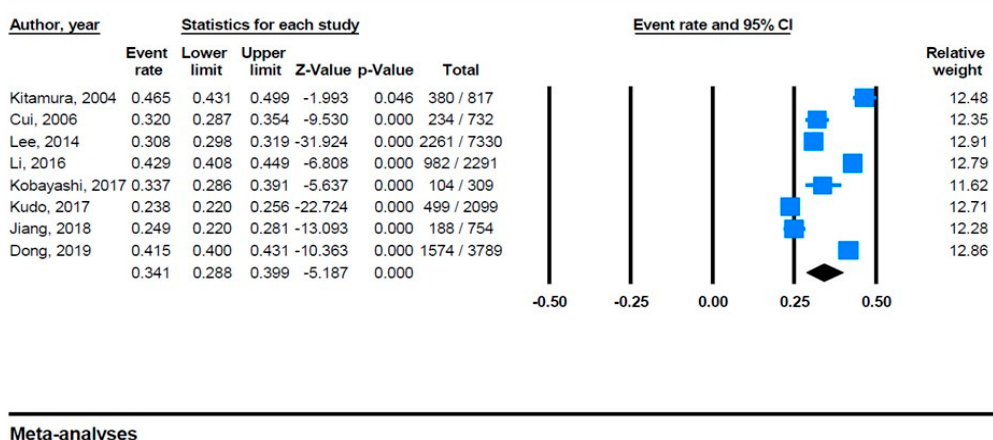
Figure 2. Meta-analyses of carotid plaque prevalence.